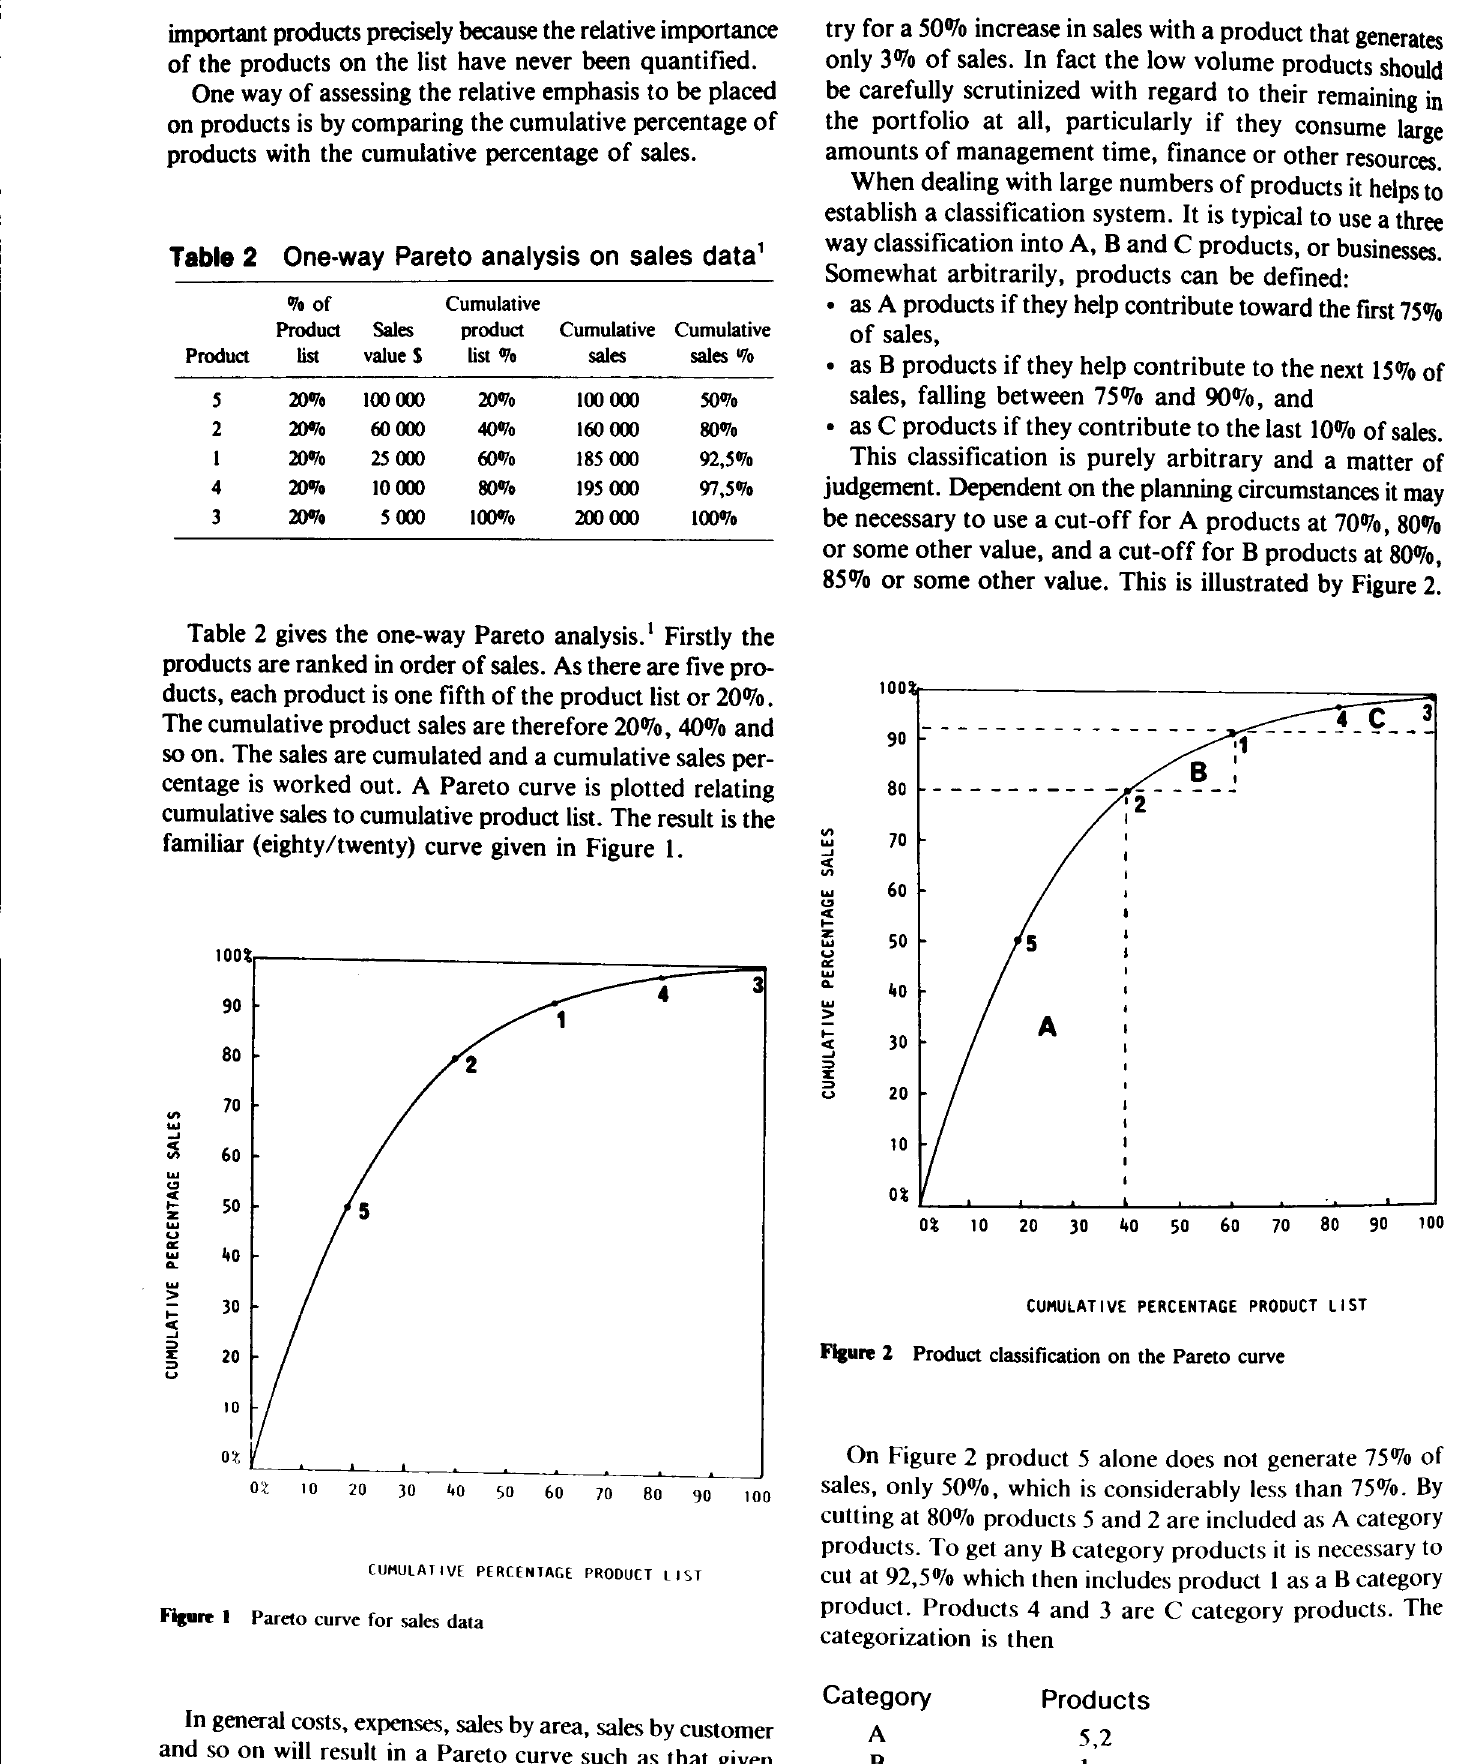
Flpre 1 Pareto curve for sales data